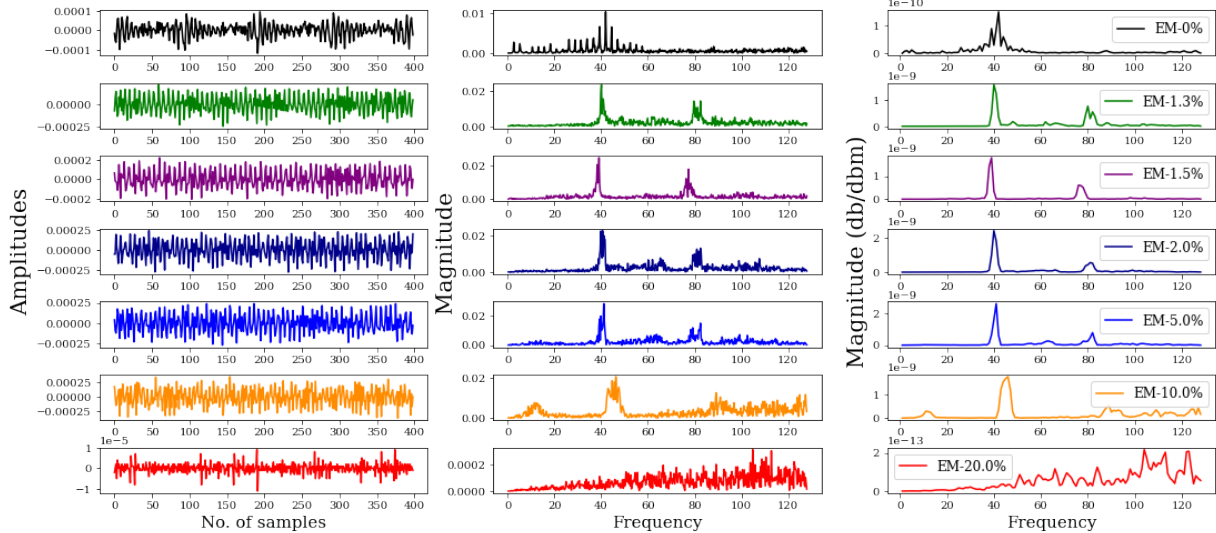
Figure A8. CR differentials and their FFT and PSD outputs at 1500 RPM for the emulsion